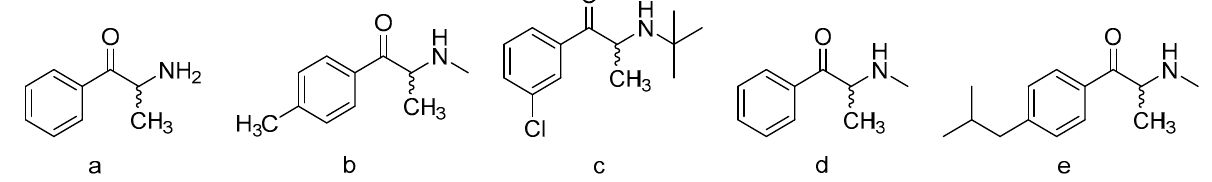
Figure 1. Chemical structures of ( a ) cathinone, ( b ) mephedrone, ( c ) bupropion, ( d ) methcathinone, and ( e ) 4-isobutylmethcathinone (IBMCat).